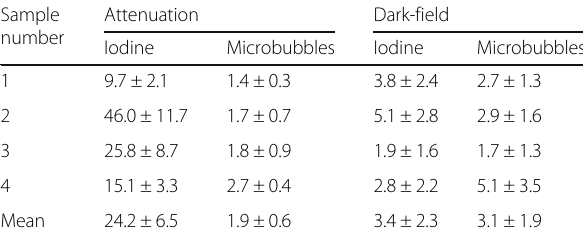
Table 1 Contrast-to-noise-ratio of the contrast agents calculated in both the attenuation and dark-field modes Sample Attenuation number